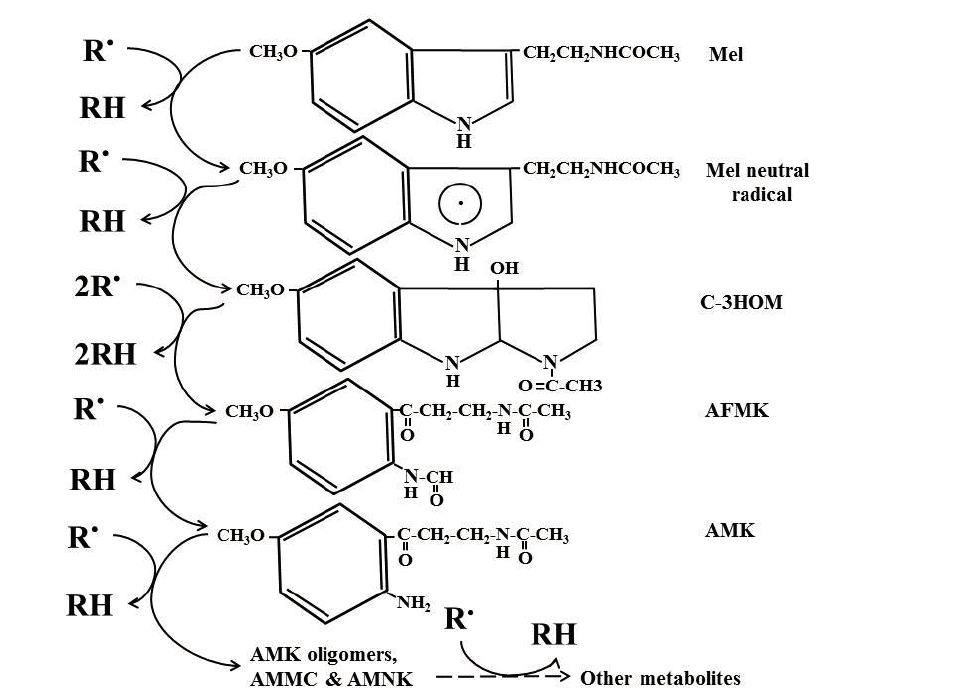
Figure 3. Cascade reaction of melatonin interaction with free radicals and its mebabolites. R.: radical; RH: reduced agent; Mel Melatonin; C-3HOM: cyclic 3-hydroxymelatonin; AFMK: N 1 -acetyl- N 2 -formyl-5-methoxyknuramine; AMK: N -acetyl-5-methoxyknuramine; AMCC: 3-acetamidomethyl-6-methoxycinnolinone; AMNK: N 1 -acetyl-5-methoxy-3-nitrokynuramine; dashed arrow: unidentified